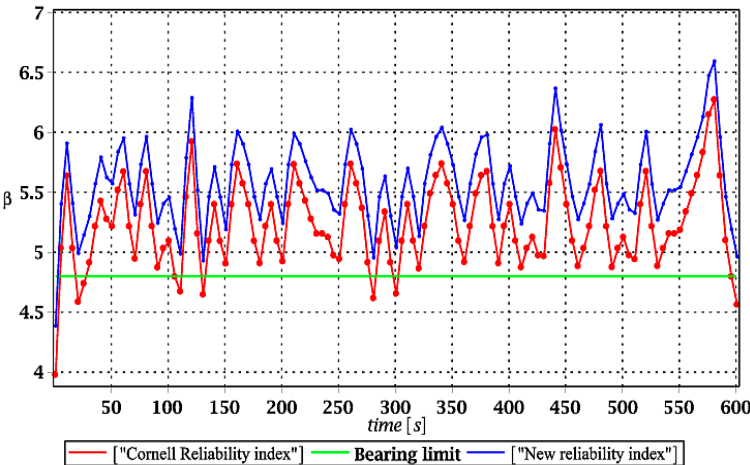
Figure 16. The comparison of dynamic reliability indices for uncertain thickness.